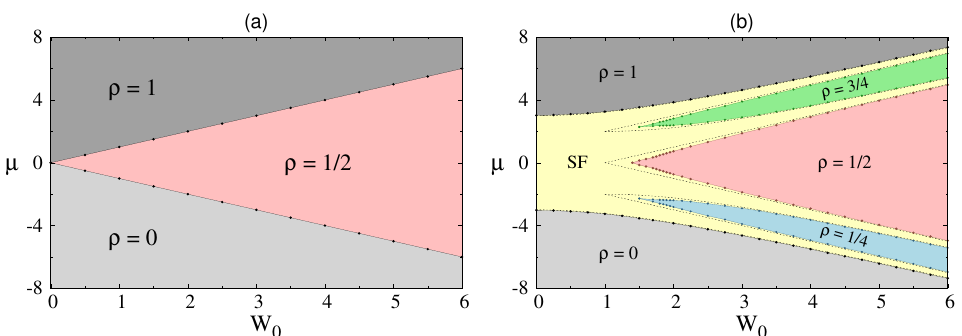
Figure 5: Phase diagram of HCBs on the honeycomb lattice as function of the chemi- cal potential ( µ ) and the alternating on-site potential strength along the y -direction ( W ): (a) in the atomic limit; and, (b) in the presence of a finite hopping t = 1.0. 0 The ρ = 0 (light grey), ρ = 1 / 2 (pink) and ρ = 1 (dark grey) regions denote the empty phase, the charge-density-wave insulator at half-filling and the Mott insulator at filling-fraction 1, respectively. The blue (green) regions indicate the dimer insu- lator at 1 / 4 (3 / 4)-filling. The yellow region depicts the superfluid phase. The solid lines with points indicate phase boundaries obtained using SSE (for 20 × 20 lattice with β = 120), whereas the dashed lines indicate the calculated band